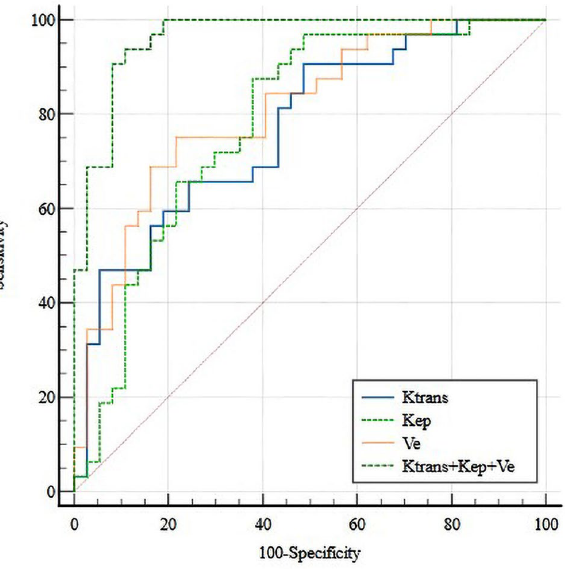
Figure 3. ROC curve of important texture-derived parameters in differentiating between thymic cancer and thymic lymphoma Groups.